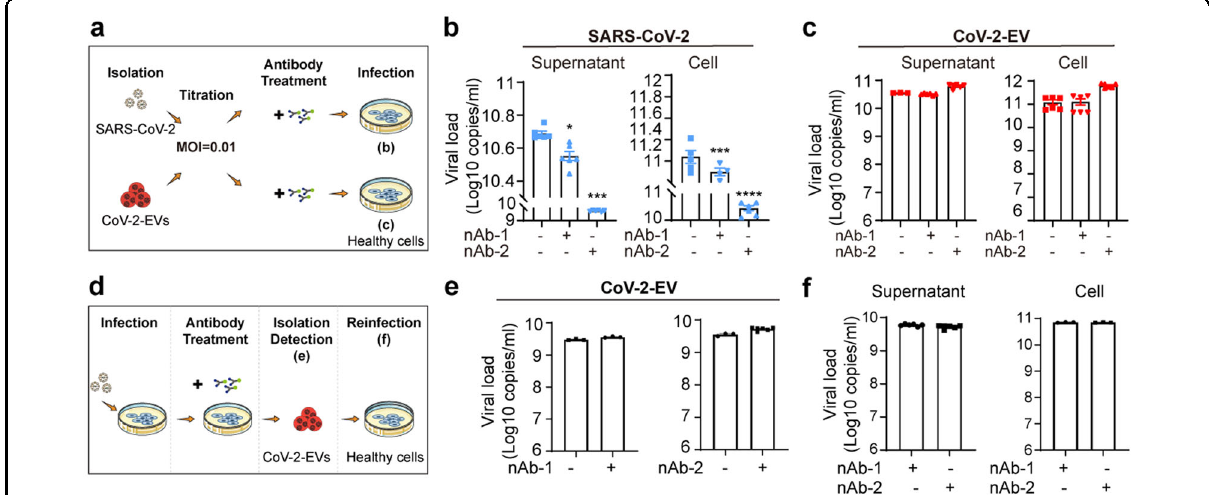
Fig. 4 CoV-2-EVs facilitate SARS-CoV-2 escape from neutralizing antibodies and establish a productive infection. a Schematic representation of SARS-CoV-2 and CoV-2-EV infection experiments. b , c qRT-PCR analysis of SARS-CoV-2 levels in cells and supernatant after infection by viral particles ( b ) and CoV-2-EVs ( c ) pretreated with nAb-1 or nAb-2. d Schematic representation of secondary infection experiments. Vero E6 cells were infected with live SARS-CoV-2 virus for 1 h, and then neutralizing antibodies or control IgG proteins were added. CoV-2-EVs were isolated from the supernatant by differential centrifugation as described in Fig. 1b. Naïve Vero E6 cells were incubated with CoV-2-EVs for 24 h and then replaced with fresh medium. Then, the viral copies were tested by qRT-PCR. e qRT-PCR analysis of viral copies in CoV-2-EVs from d . f qRT-PCR analysis of SARS-CoV-2 levels in cells and supernatant after secondary infection by CoV-2-EVs pretreated with nAb-1 or nAb-2. Data are the means ± SEM of three independent experiments. * P < 0.05, ** P < 0.01, *** P < 0.001, **** P < 0.0001. Analysis was performed using one-way